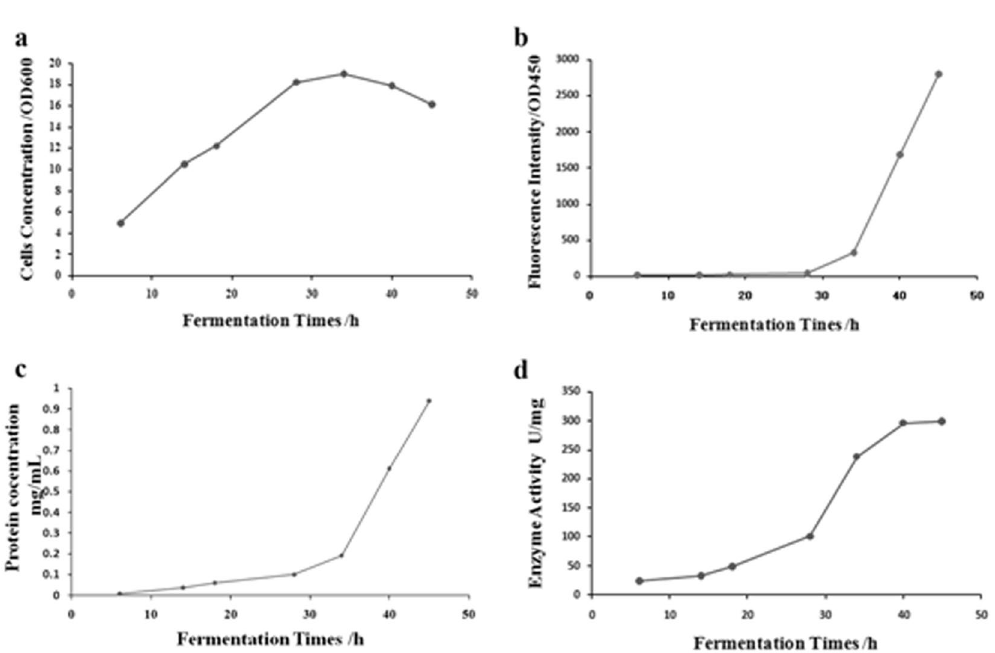
Figure 6. Analysis the extracellular secretion of sfGFP-ARG1 in fed-batch fermentation condition. ( a ) Cells concentration in fed-batch fermentation condition; ( b ) Fluorescence intensity of extracellar secretion sfGFP- ARG1 in fed-batch fermentation condition; ( c ) Protein concentration of extracellar secretion sfGFP-ARG1 in fed-batch fermentation condition; ( d ) Enzyme activity of extracellar secretion sfGFP-ARG1 in fed-batch fermentation